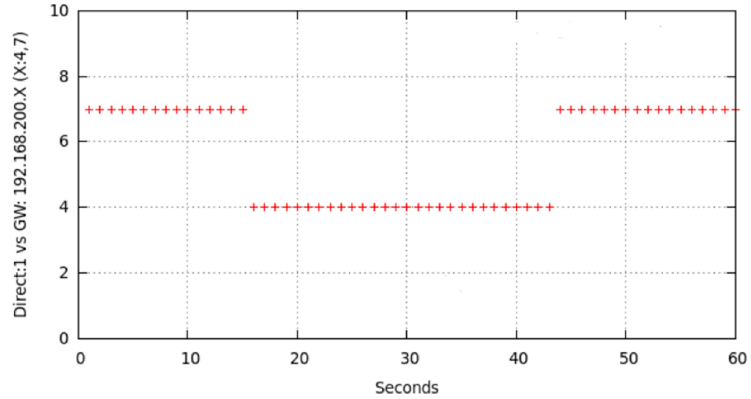
Figure 16. Deactivation effect of intermediate node7 WiFi interface (t DOWN = 2 s) at instant t = 10.